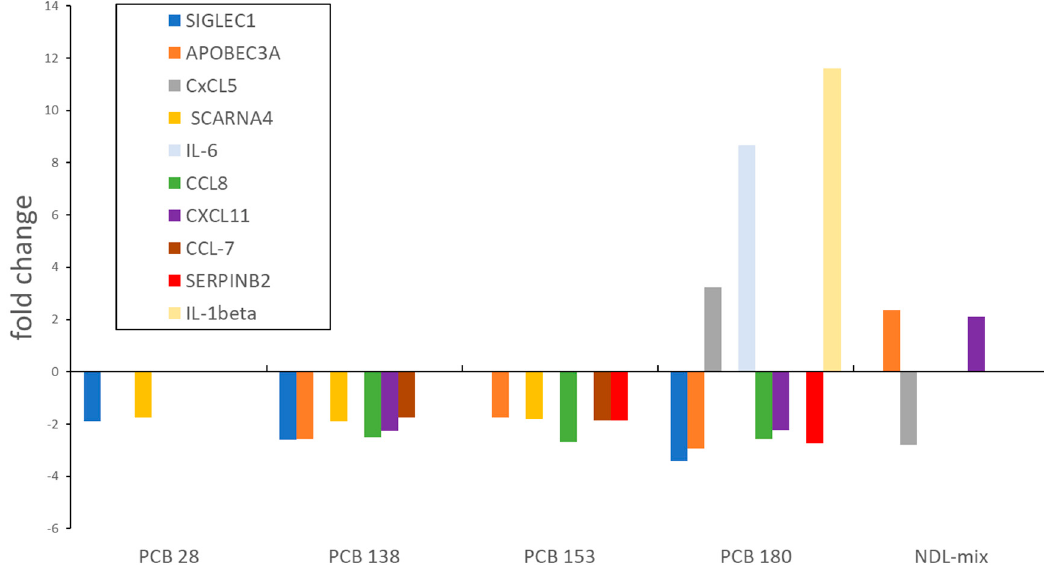
Figure 2. Some genes of interest commonly dysregulated by non-dioxin-like (NDL)-PCBs. Figure 2 displays a selection of commonly dysregulated genes (fold change) for the NDL- PCBs (congener 28, 138, 153, 180, as well as the NDL-PBC mixture (NDL-mix). Some of these genes (IL-6, CCL-7, IL1- α , IL1- β ) were confirmed by qRT-PCR. The gene CXCL11 was (-4.32 fold) downregulated in PBMCs stimulated with DL-PCBs and upregulated with NDL-PCBs (2.1 fold) mix. PCB 180 exposed PBMCs showed a downregulation of CXCL11 of − 2.2 fold.